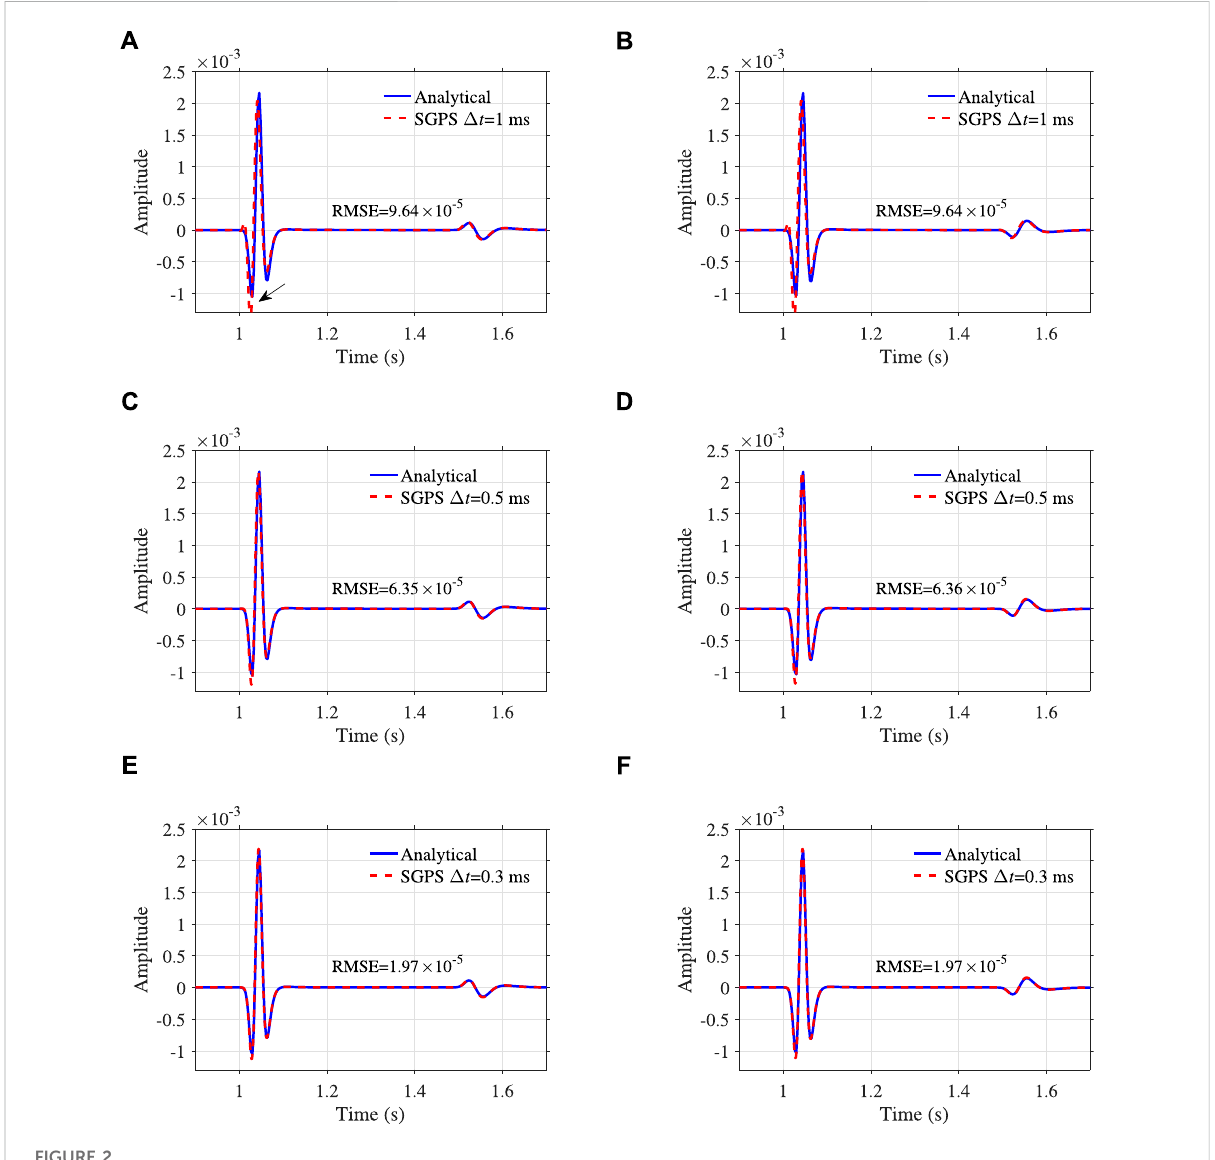
FIGURE 2 Comparison of traditional SGPS numerical solutions with analytical solutions where (A,C,E) depict v x , (B,D,F) show v z . The arrows mark visible amplitude differences caused by time